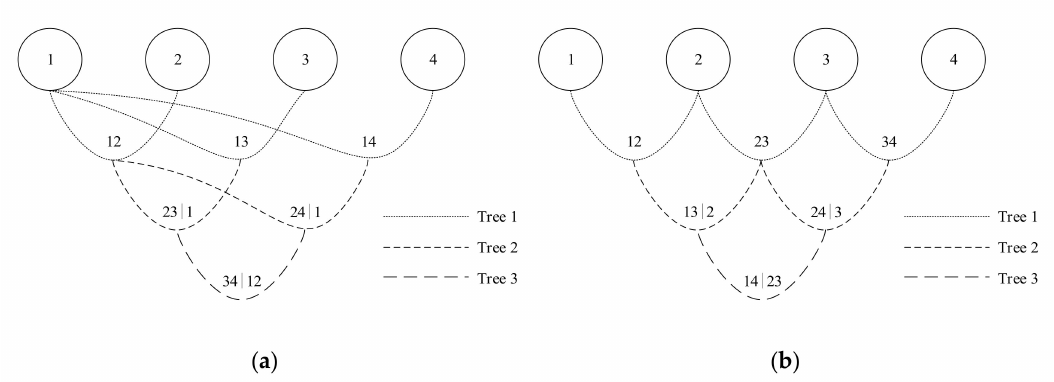
Figure 2. Four-dimensional vine copula structure, where each edge is associated with a pair-copula: ( a ) A C-vine structure with 4 variables, 3 trees, and 6 edges, where node 1 is the root node; ( b ) A D-vine structure with 4 variables, 3 trees, and 6 edges. Specifically, the numbers at each edge represent the bivariate copula between any adjacent